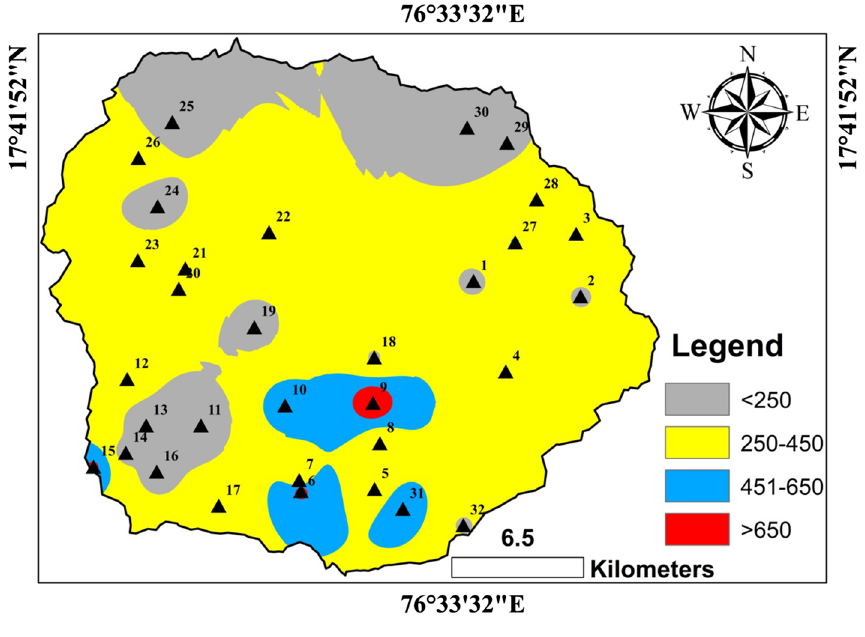
Fig. 7 Geospatial distribution of TDS